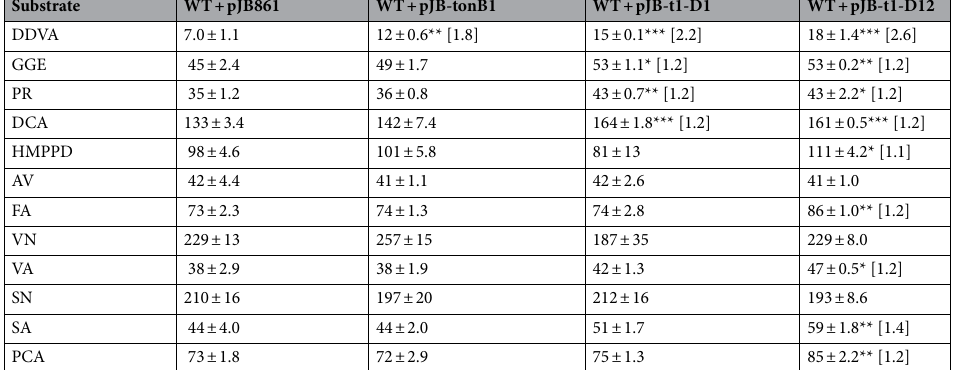
Table 2. The conversion rates of lignin-derived aromatic compounds by SYK-6 cells overexpressing the tonB1 operon genes. The conversion rates were calculated from the results of Fig. S8 using the decreasing amount of each substrate at the time interval (DDVA, 0–5.0 h; GGE, 0–1.5 h; PR, 0–2.0 h; DCA, 0–0.5 h; HMPPD, 0–0.5 h; AV, 0–2.0 h; FA, 0–1.0 h; VN, 0–0.5 h; VA, 0–2.0 h; SN, 0–0.5 h; SA, 0–1.5 h; PCA, 0–1.0 h), where almost linear conversions of the substrates were observed. Each value is the average ± the standard deviation of three independent experiments. * P < 0.05, ** P < 0.01, *** P < 0.001 (values indicating significance between the conversion rates of SYK-6 cells harboring pJB861 and SYK-6 cells harboring pJB-tonB1, pJB-t1-D1, or pJB- t1-D12 from unpaired, two-tailed t -test). The P value of each field without an asterisk, P > 0.05. Values in the brackets indicate fold change between the conversion rates by SYK-6 cells harboring pJB861 and SYK-6 cells harboring pJB-tonB1, pJB-t1-D1, or